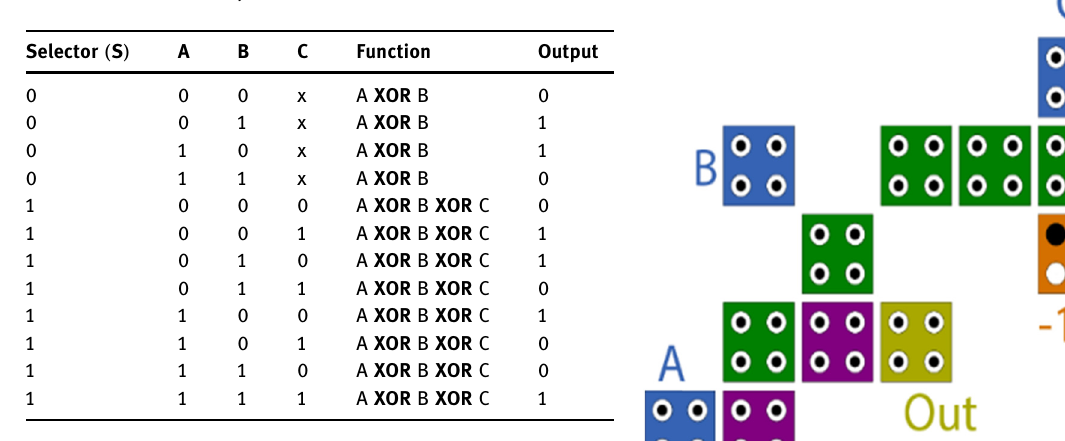
Table 1: The functionality table of DFXOR